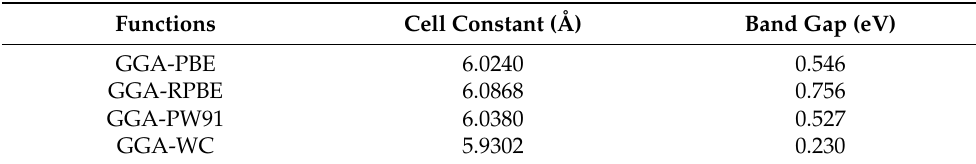
Table 3. Optimized results by different exchange-correlation functions.